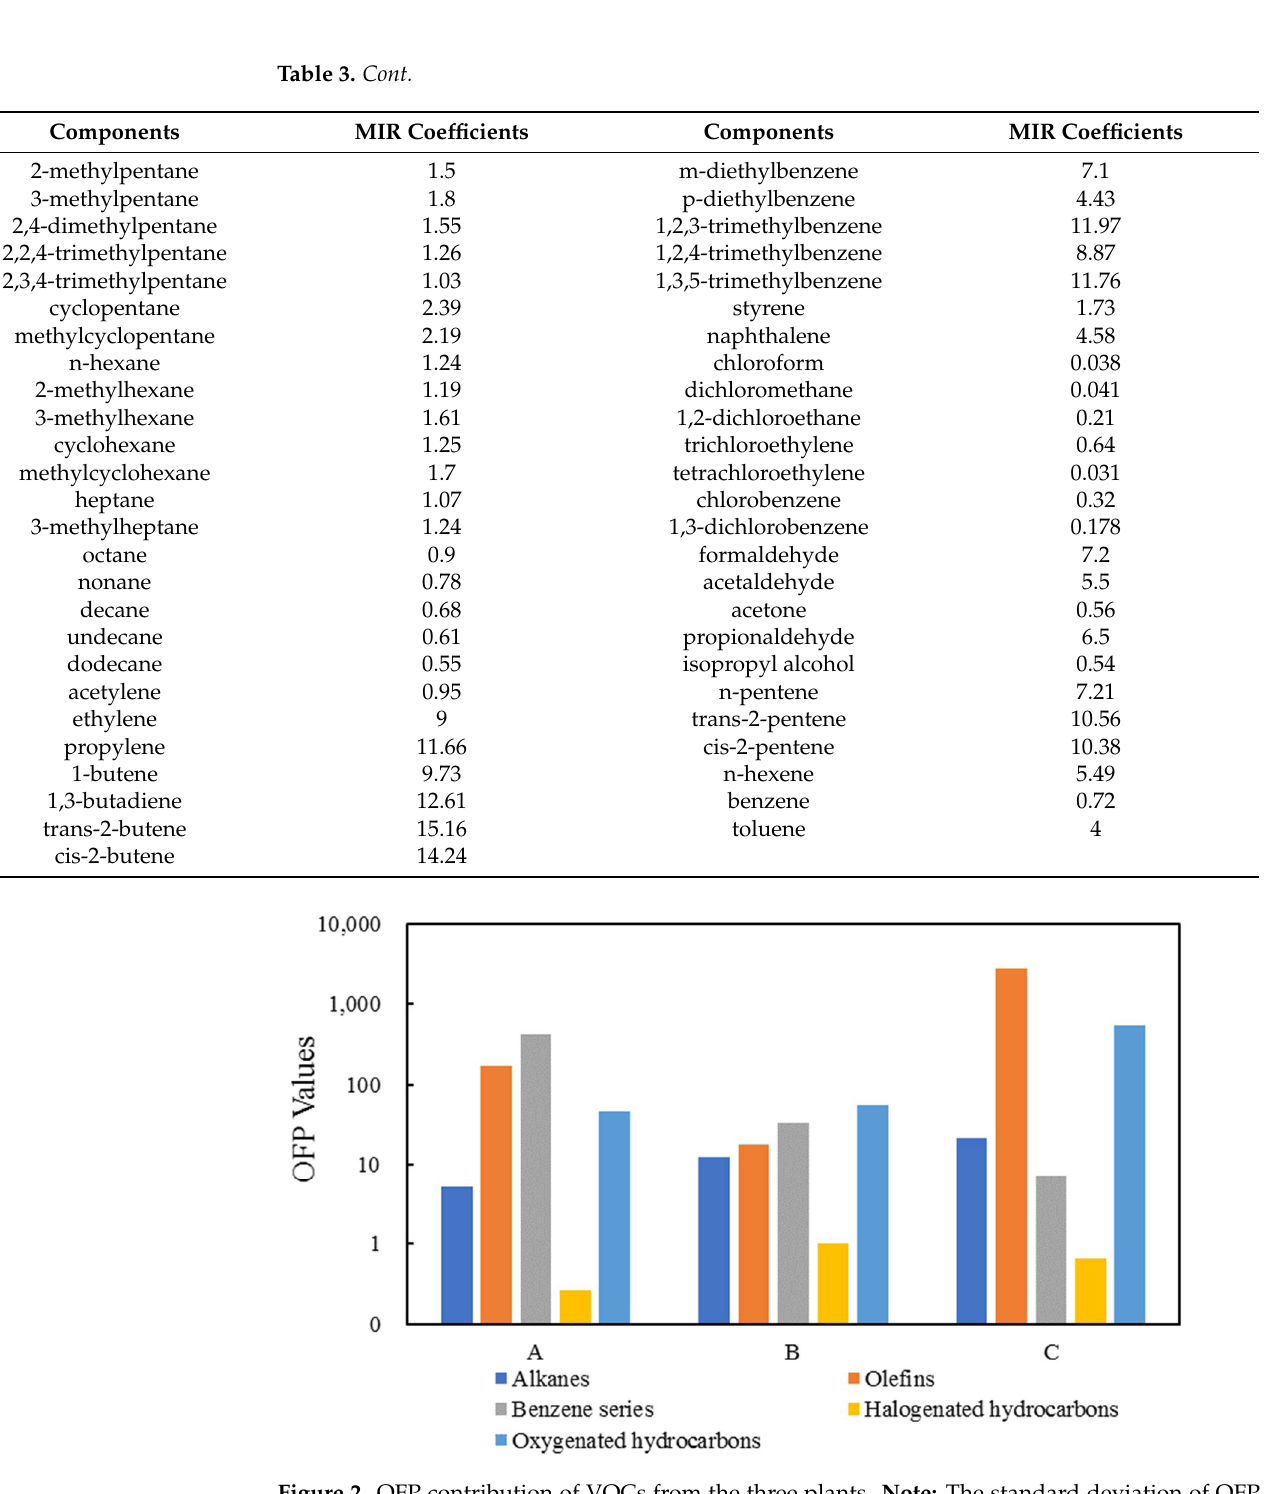
Figure 2. OFP contribution of VOCs from the three plants. Note: The standard deviation of OFP values of alkanes, olefins, benzene series, halogenated hydrocarbons, oxygenated hydrocarbons were ±21.48, ±2743.49, ±420.67, ±1.01 and ±539.03, respectively. Table 3. MIR coefficients of VOCs for OFP calculation.